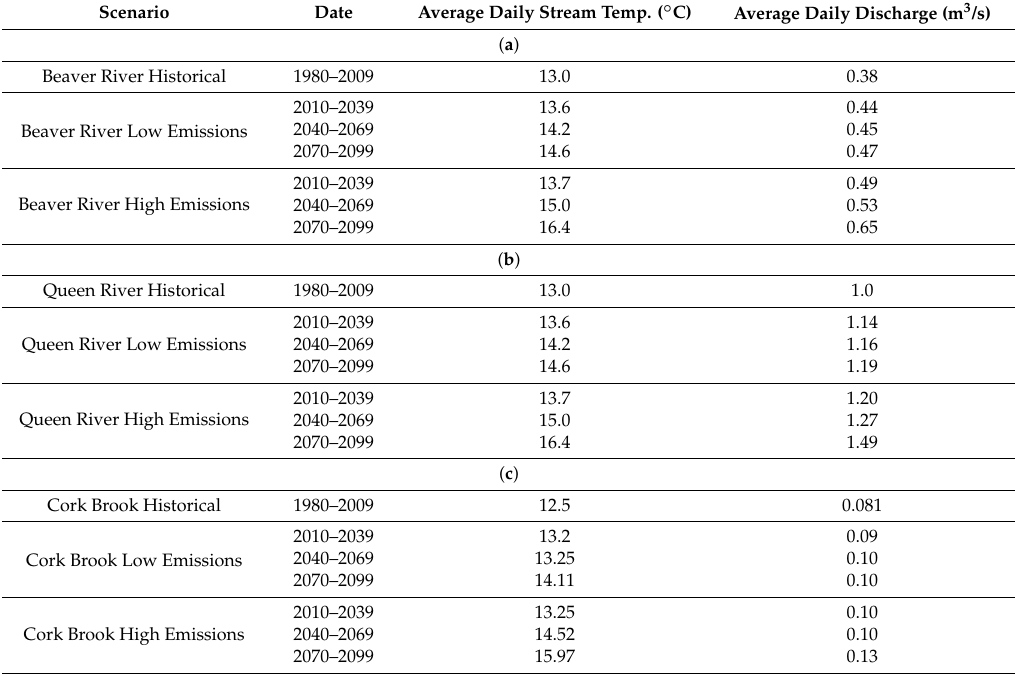
Table 7. Average stream temperature and streamflow simulated with climate change variables